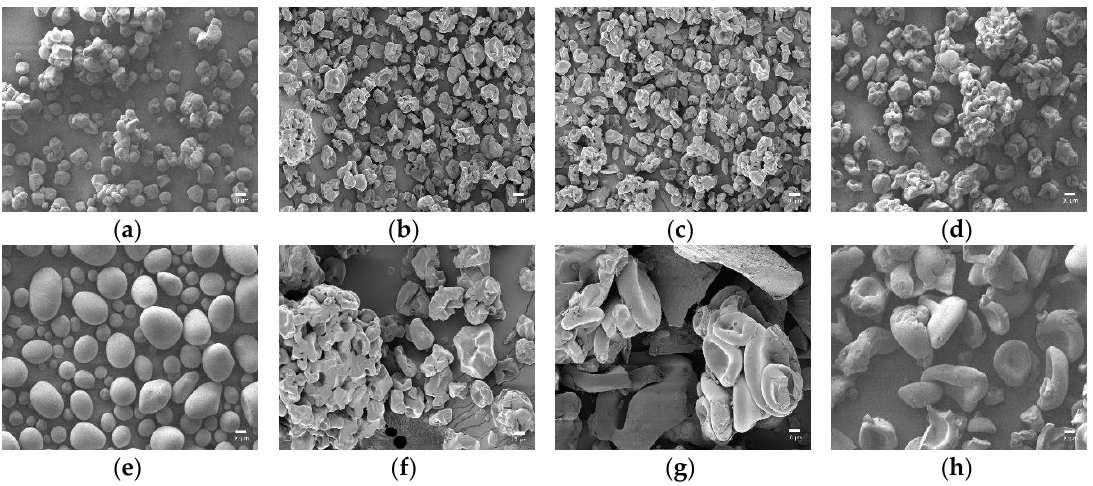
Figure 2. The FE-SEM images of native starch and starch aldehydes ( × 1000, scale bar: 10 μ m): ( a ) CS; ( b ) CS10; ( c ) CS20; ( d ) CS30; ( e ) PS; ( f ) PS10; ( g ) PS20; ( h ) PS30.